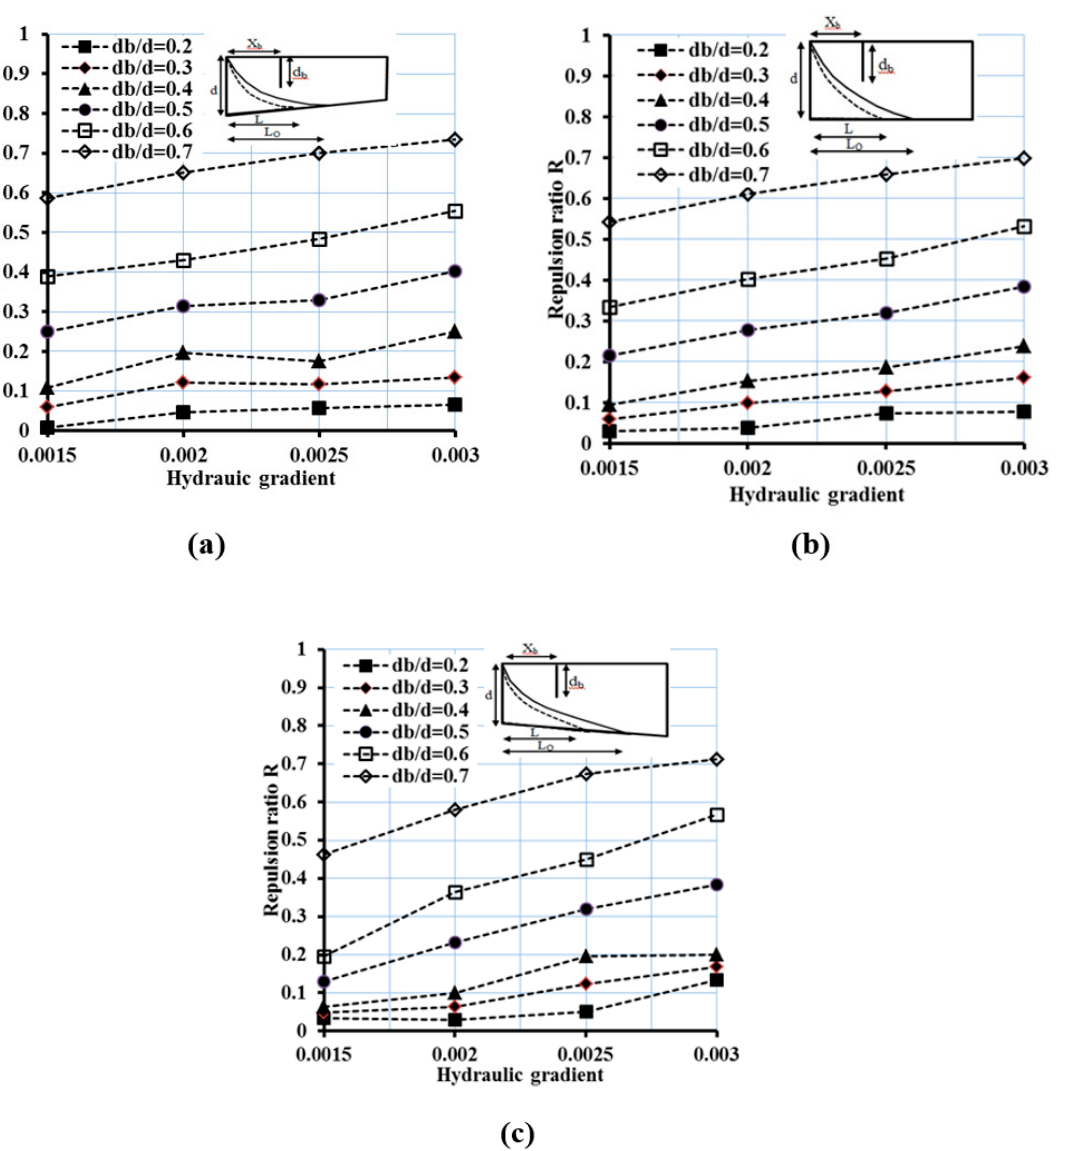
Figure 9. Relationship between the hydraulic gradient and R for different bed slopes tan β : ( a ) 0.02, ( b ) 0.0, and ( c ) − 0.02.